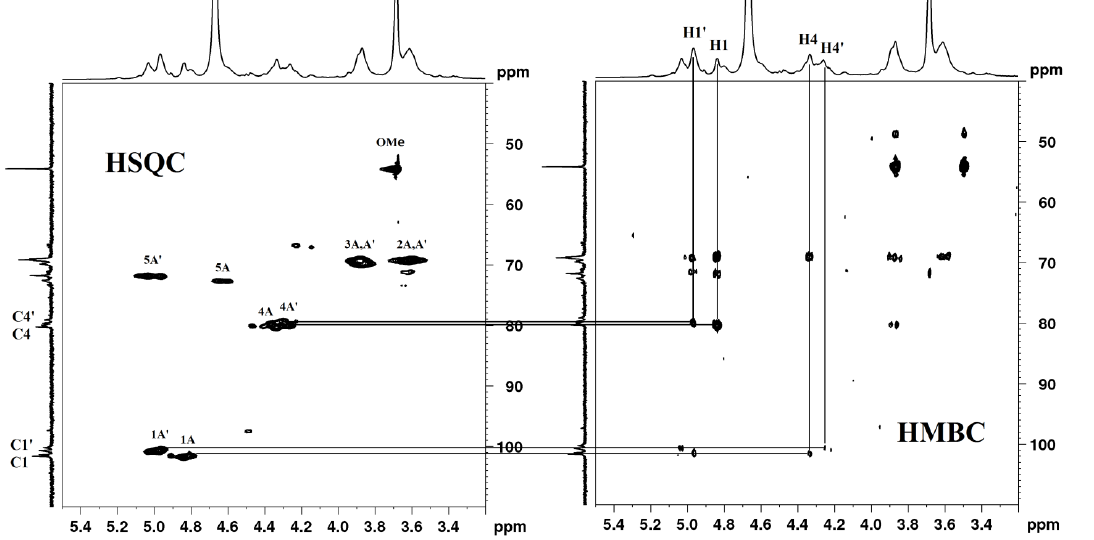
Table 2. 13 C NMR and 1 H NMR chemical shifts (ppm) for TPS1-2a and/or TPS1-2b.